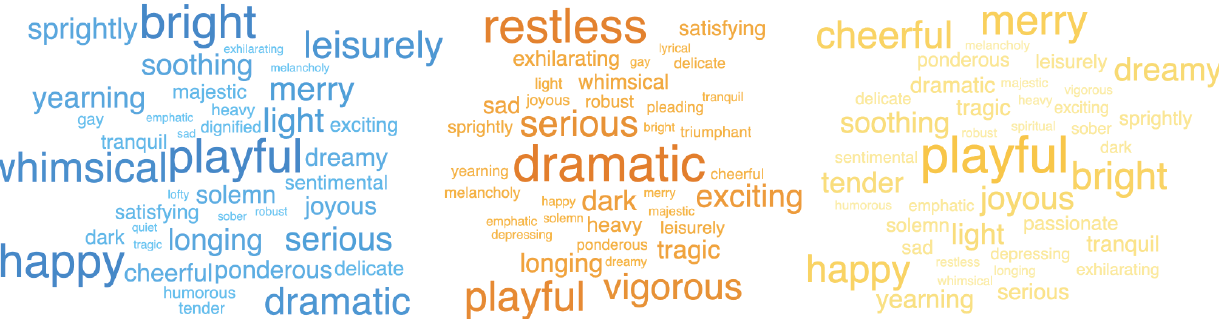
Figure 8. Results of Experiment 2 with Pump-and-Vibe. Adjectives chosen by participants for (left to right): music stimuli M1–M6 (auditory only, shown in blue); tactile stimuli T1–T6 (tactile only, shown in orange); combined stimuli C1–C6 (auditory and tactile, shown in yellow). Text size relates directly to frequency of